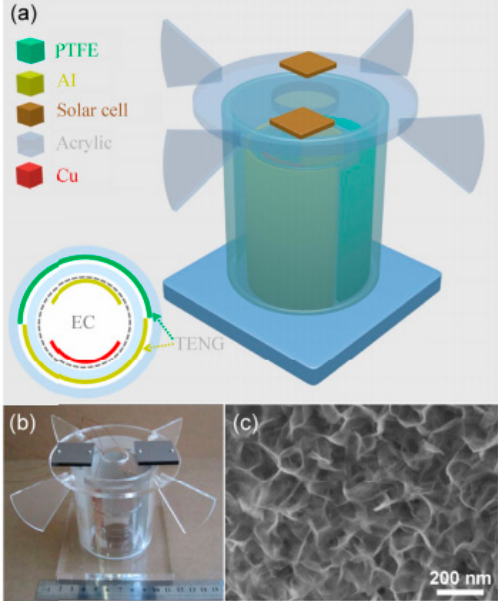
Figure 10. ( a ) Schematic view of the main components of the hybrid energy cell developed by Wu et al. [157]. ( b ) Image of the fabricated hybrid energy cell that includes solar cells and electrochemical cells placed on and in the TENG, respectively. ( c ) SEM image of Al film surface of the TENG, which was modified using nanostructures. Reprinted with permission from [157]. Copyright ©2014, Tsinghua University Press and Springer ‐ Verlag Berlin Heidelberg.